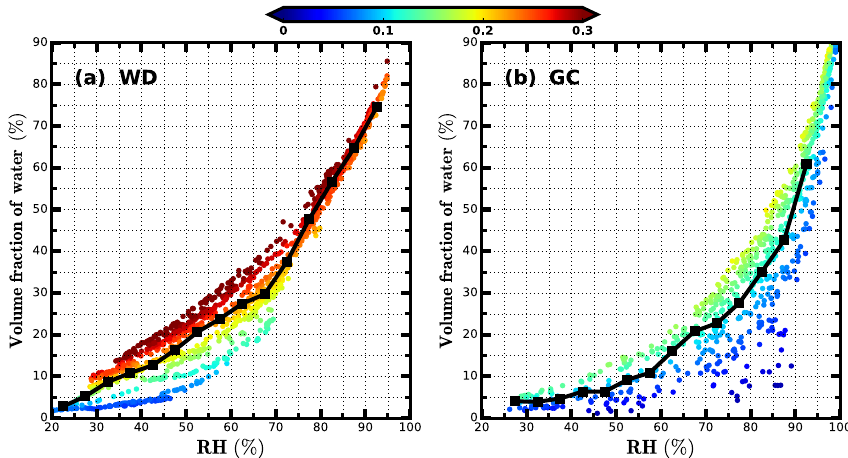
Figure 11. Volume fractions of water in total volume of ambient aerosols during the Wangdu (WD) and Gucheng (GC) campaigns. X axis represents measured ambient RH. The y axis represents volume fractions of water. Colours of scatter points represent corresponding κ Vf . Black solid lines in panels (a) and (b) show the average volume fractions of water under different ambient RH conditions.